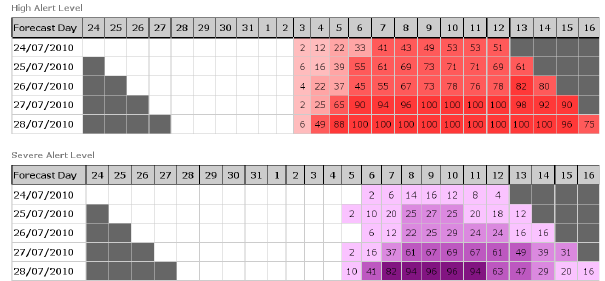
Fig. 11. Persistence diagrams of the forecasts shown in Fig. 10, showing the probability (%) of exceeding the high and severe alert level over five consecutive forecasts issued from 24 to 28 July 2010.